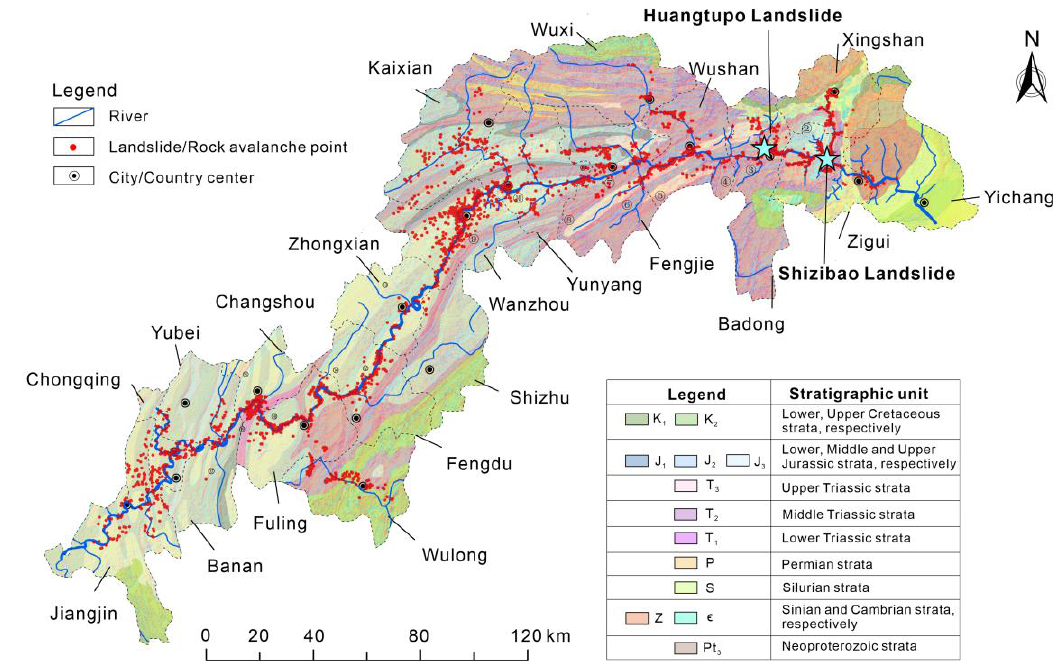
Figure 7. Geological map of TGRA showing the locations of landslides and rock avalanches (Geological map from Tang et al. 2019 [42]).